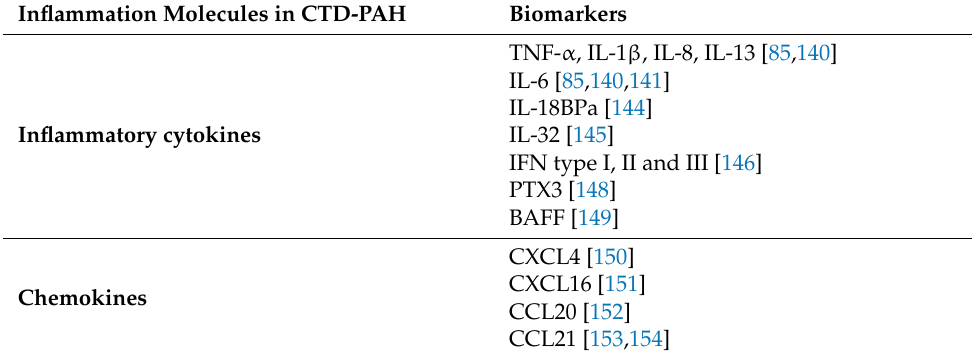
Table 3. Biomarkers of inflammation in